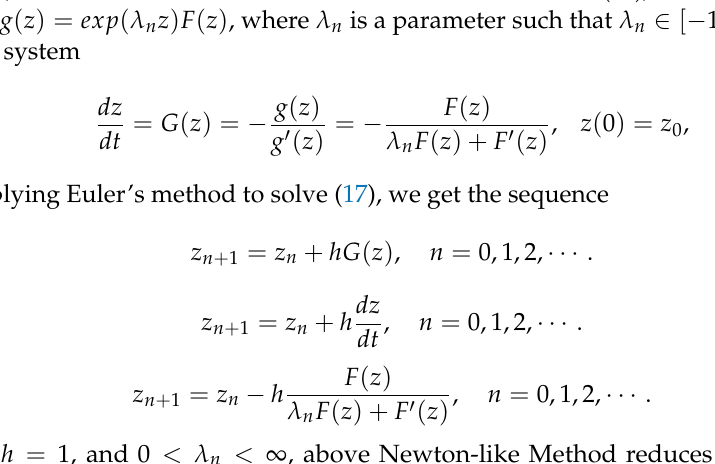
Figure 3. Basin of attraction for function Example 2, F 2 ( z ) = ( 2 z − 1 ) method (2), ( b ) Damped Newton method (8) at h = 0.50, ( c ) Damped Proposed method (12) at h = 0.50 and λ =